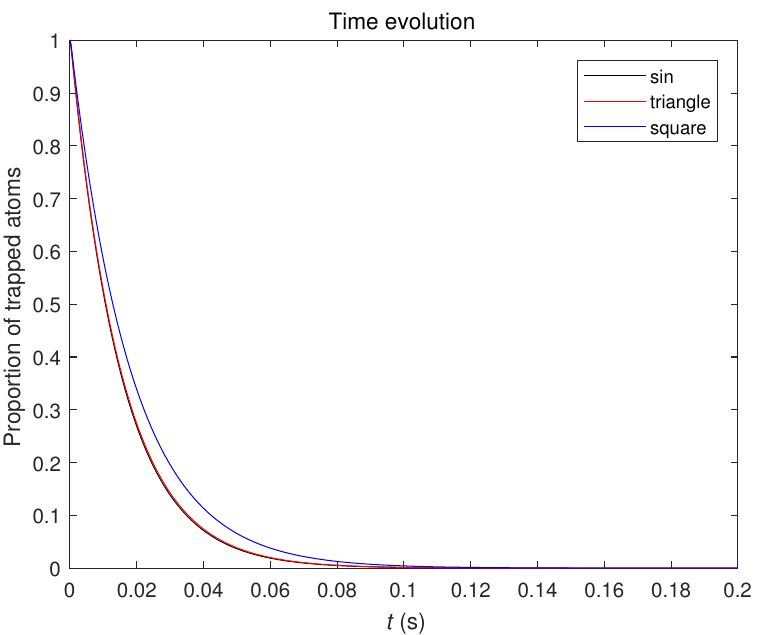
Figure 6. Simulated time evolution of the lowest level population vs time (s) at the frequency ω = 2 ω 0 of the modulation signal, within the model described above: black—the sinusoidal modulation signal, red—the triangular modulation signal, blue—the square modulation signal.